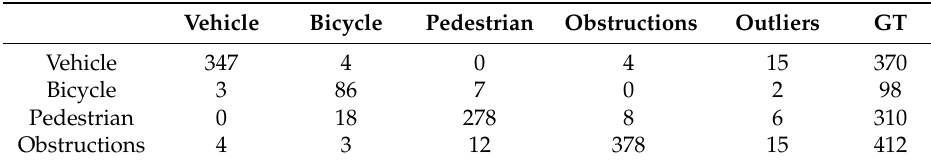
Table 6. Confusion matrix between the considered categories.